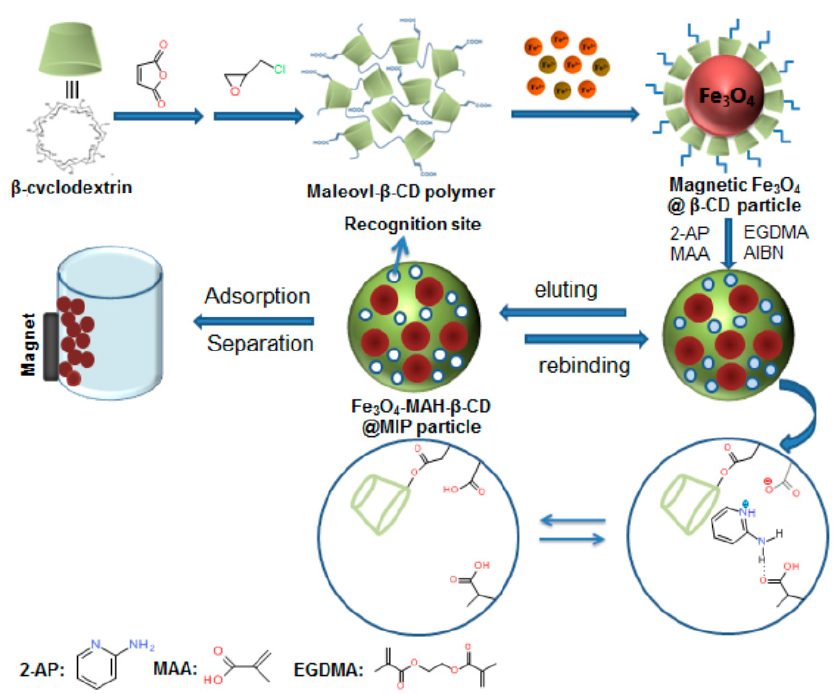
Figure 2. Scheme of preparation of Fe 3 O 4 -MAH- β -CD@MIP and application for removal of 2-aminopyridine with external magnetic field.